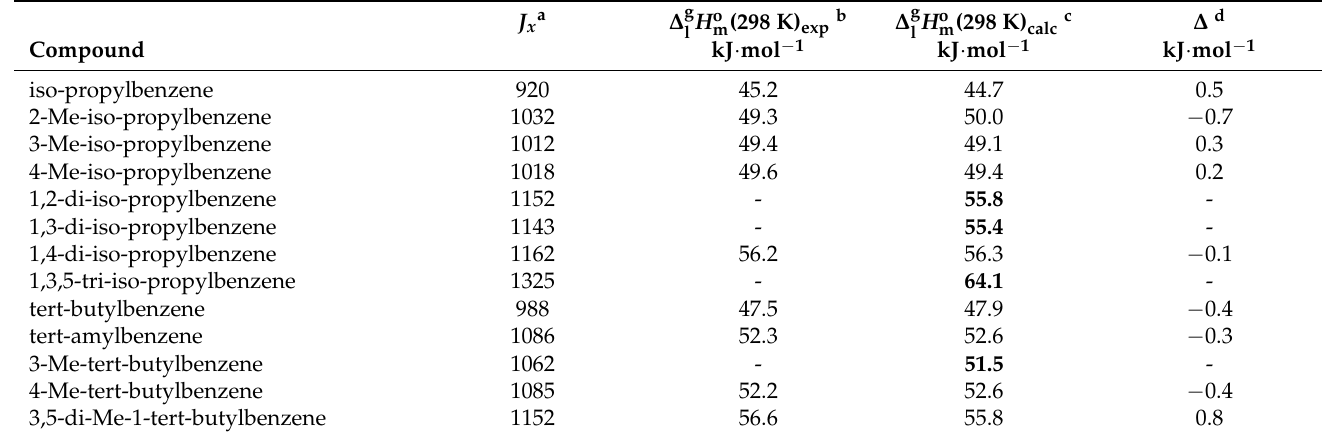
Table 5. Correlation of the vaporisation enthalpies, ∆ g with their Kovats indices on ( J x ) on